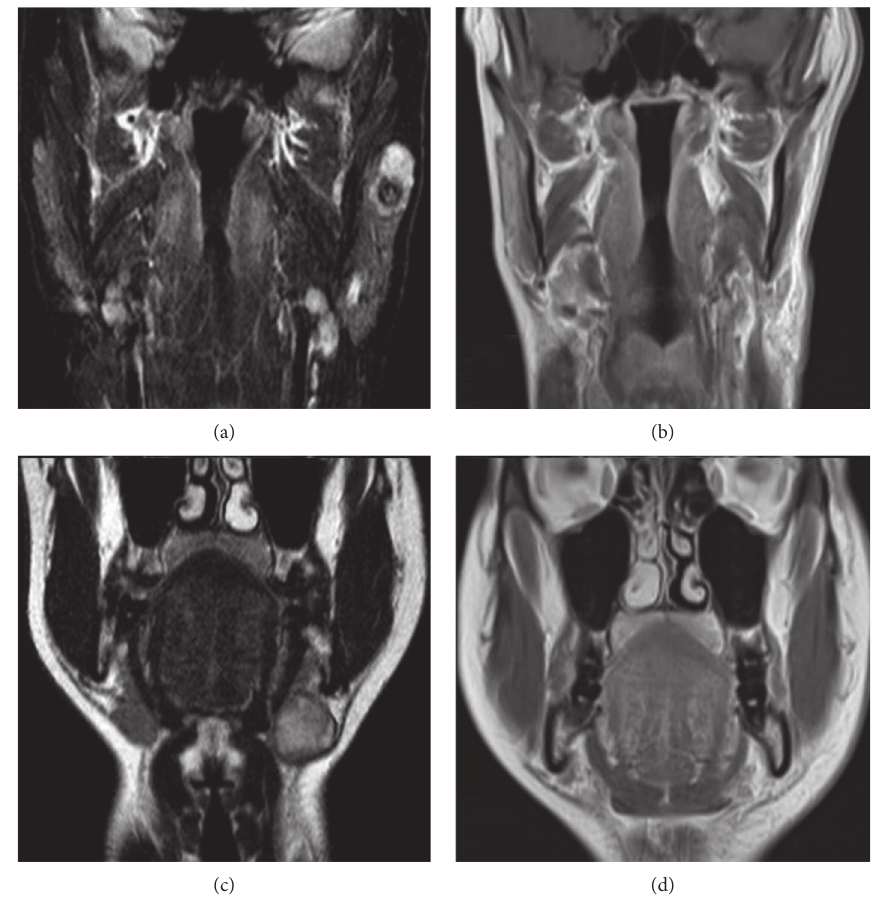
Figure 1: (a, c) Presurgery contrast-enhanced MRI of the head and neck; (b, d) 3-month follow-up MRI.